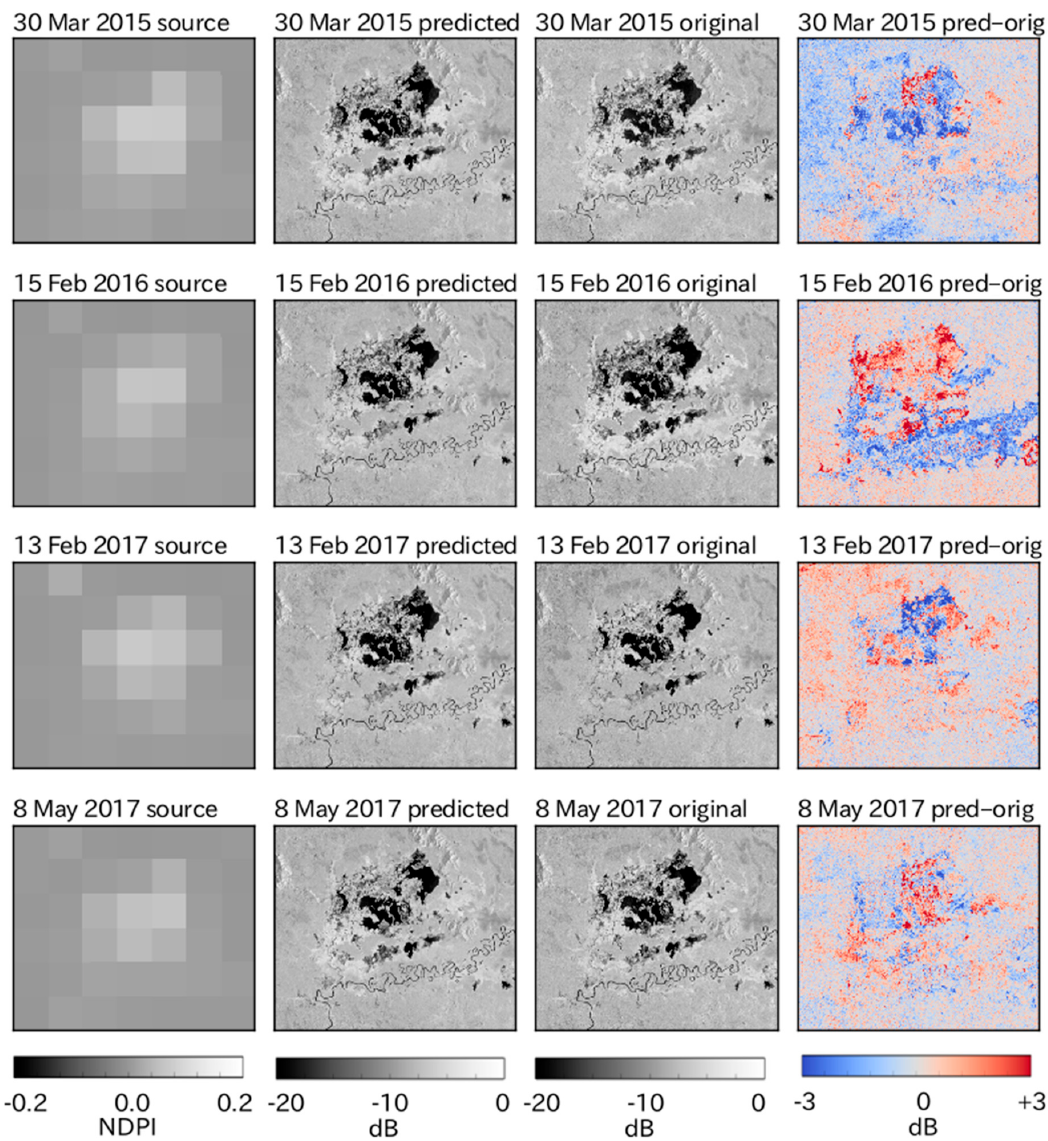
Figure 6. Image validation: bad cases. See Figure 5 for a description of the figure elements.